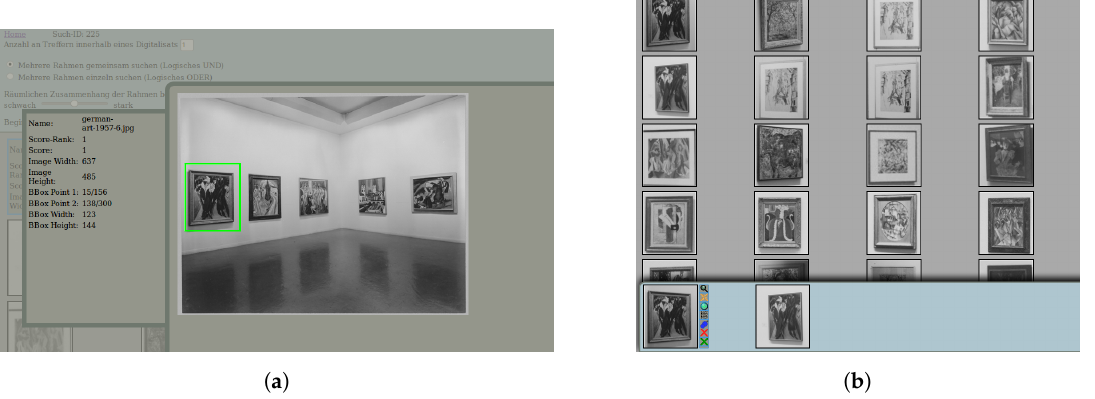
Figure 4. ( a ) The interface offers the function to enlarge search results to view entire image and metadata; ( b ) pin function to separately display correctly retrieved images. Image rights: Computer Vision Group, Heidelberg University. Displayed photographs/details belong to the Museum of Modern Art, New